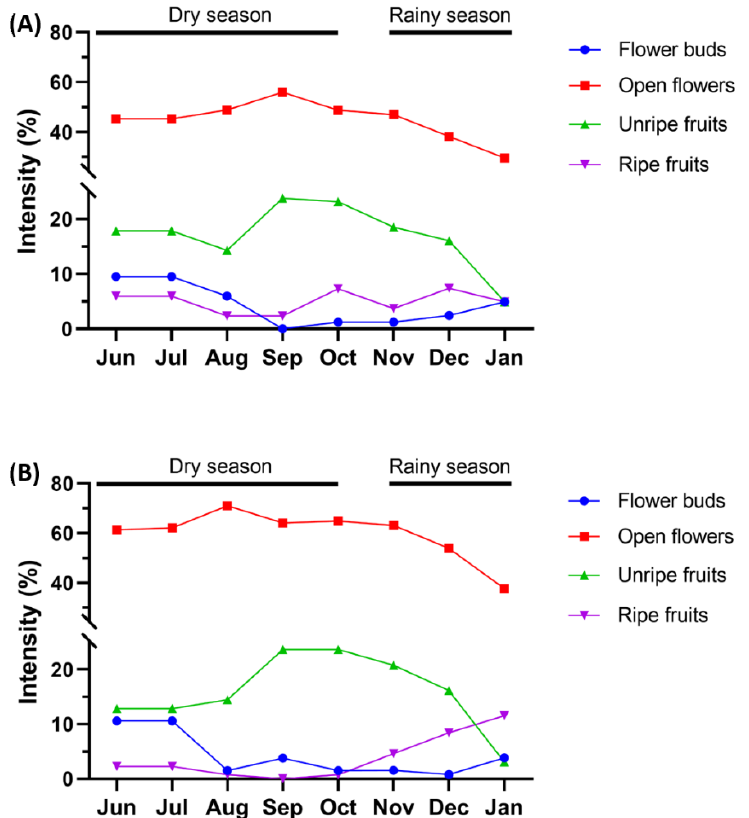
Figure 4. Intensity of phenophases of O. mapora for low-terrace ( A ) and high-terrace forests ( B ) of the Madre de Dios Region, Peru.